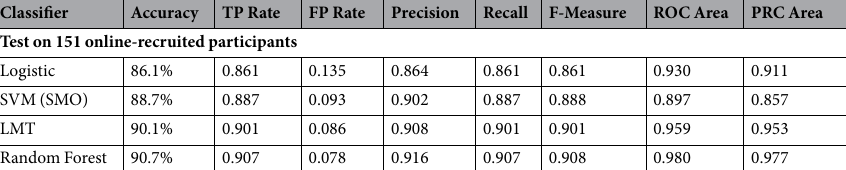
Table 7. The table reports the percentage of accuracy obtained in a test set of 151 participants (86 liars and 65 truthtellers) recruited online. In addition to accuracies, the table reports the weight average of True Positive Rate (TP Rate), False Positive Rate (FP Rate), Precision value, Recall value, F-Measure, Receiver Operating Characteristics (ROC) Area value and Precision-Recall Curve (PRC) Area